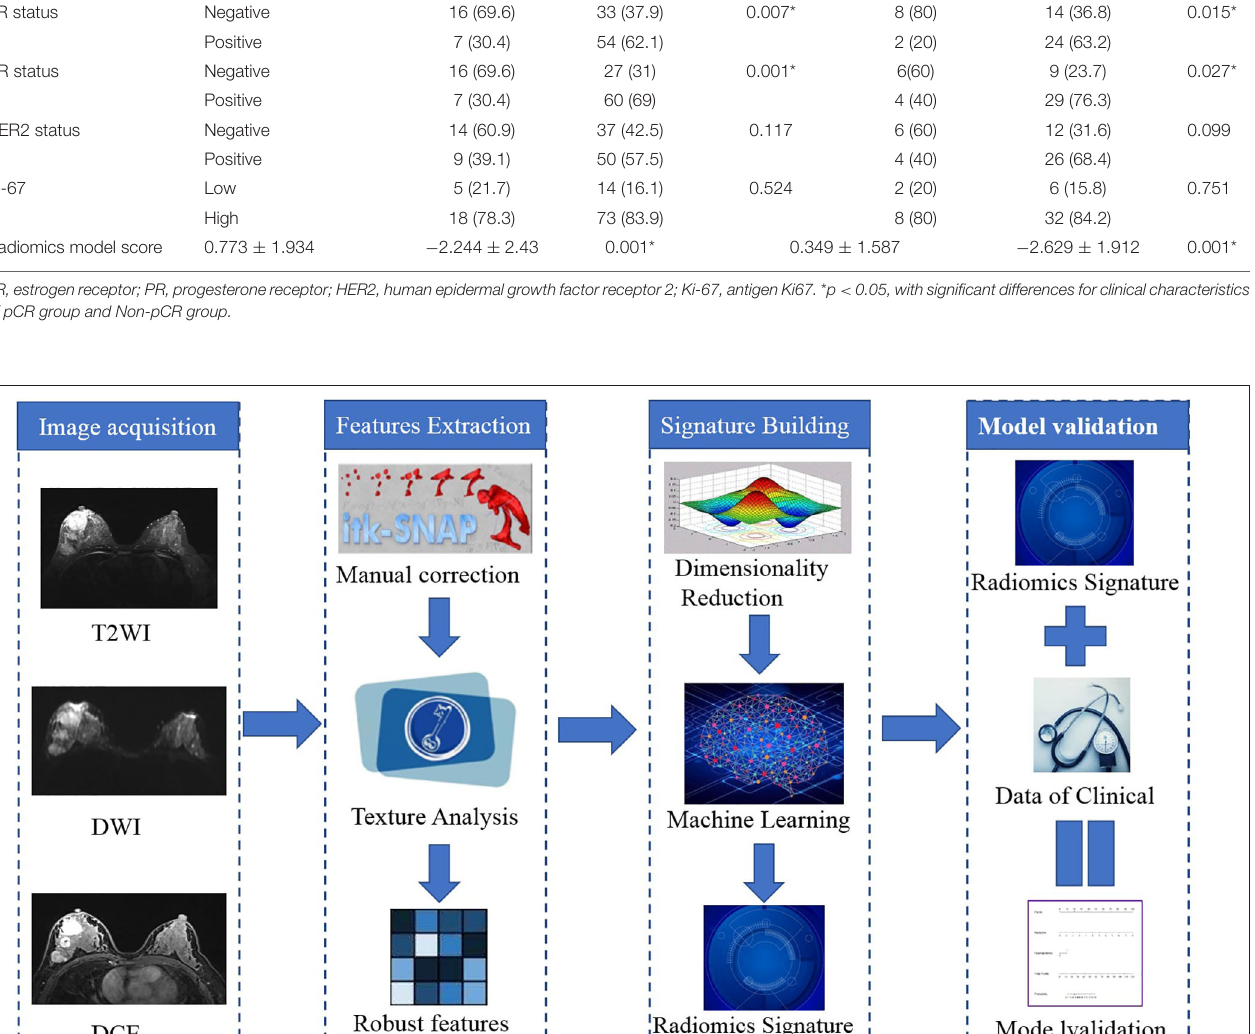
Frontiers in Oncology |